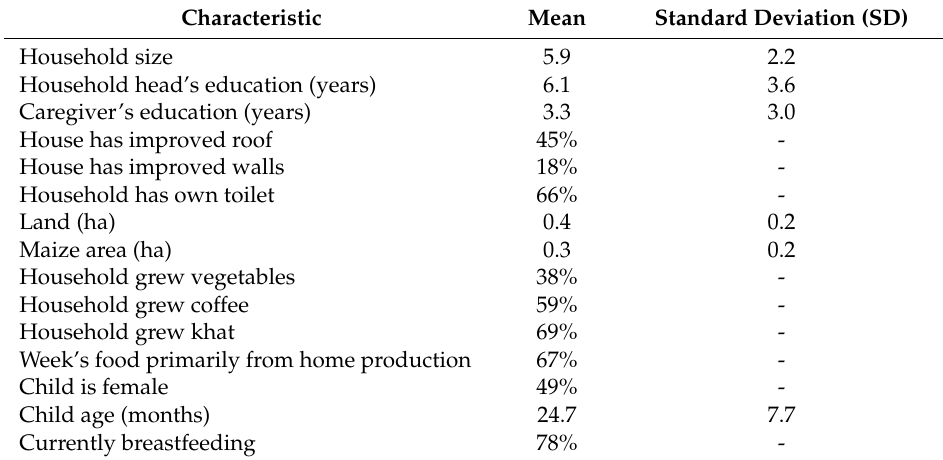
Table 1. Characteristics of households and children at the first assessment (post-harvest, n =